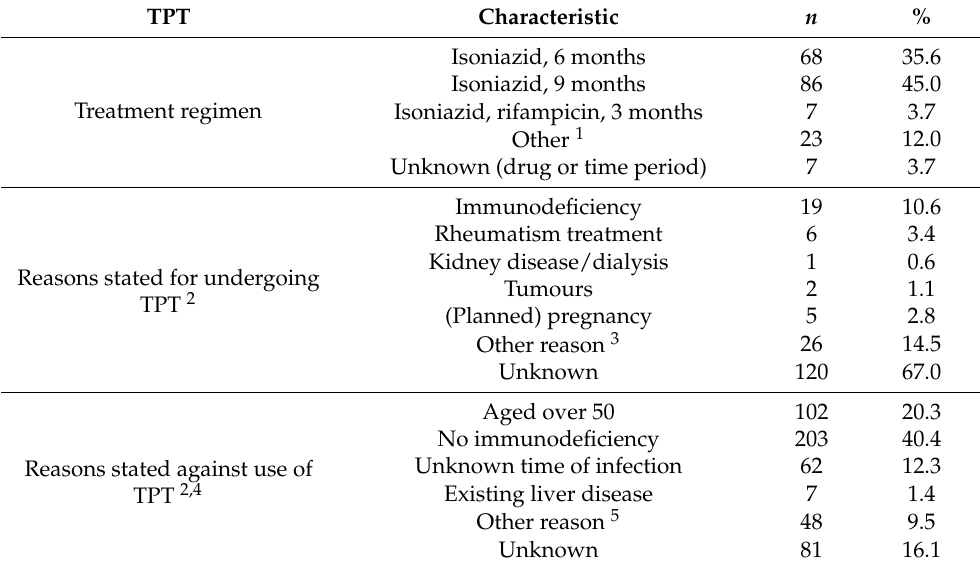
Table 3. Information provided on TPT ( n = 191; 33.2%) from survey.